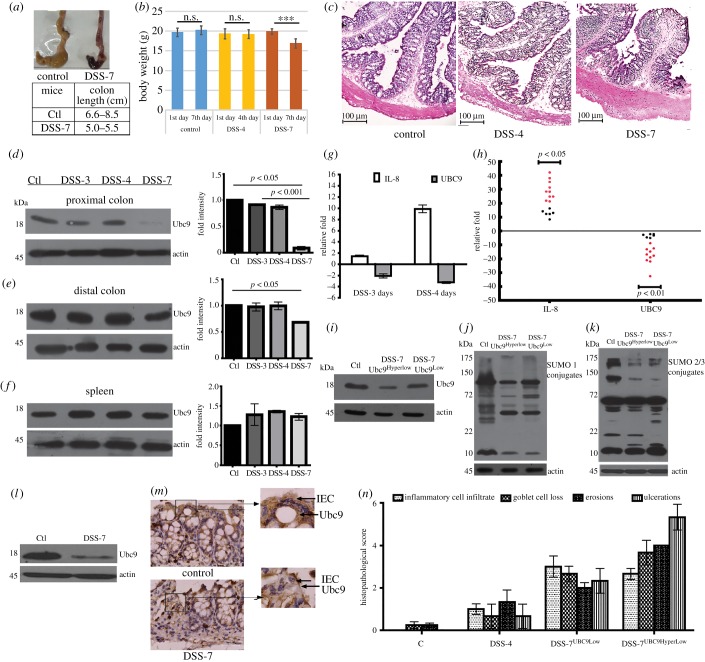
Downmodulation of Ubc9 expression in DSS-colitis mice. (a) Top, gross morphology of the caecum and colon of control and DSS-treated mice; bottom, table showing reduced lengths of the colon of control DSS-treated mice (DSS-7) (n = 6) compared with the control group. (b) Body weight of animals during the course of DSS treatment. (c) Haematoxylin and eosin staining of caecum of mice (scale bar, 100 µm) showing exacerbated inflammation in animals. Immunoblots of Ubc9 of lysates from the (d) proximal colon, (e) distal colon and (f) spleen. Densitometry analysis of Ubc9 protein shows lowered Ubc9 in inflamed tissue as represented by means ± s.e.m. from three independent experiments are shown on the right-hand panel in each (d,e,f). Actin was blotted as a loading control. (g) qPCR expression of DSS (3 and 4 days, n = 5) mice for Ubc9 and IL-8 genes of proximal colon. qPCR data were calculated as average fold change (relative to the control group). B2M and β-actin were used for normalization. (h) qPCR data of IL-8 and Ubc9 of DSS-7 mice compared with the control group represented as fold change (relative to control), each black dot represents one mice. Immunoblot representing the downmodulation of Ubc9 (i) and global SUMOylation: SUMO-1 proteome (j) and SUMO-2/3 proteome (k) in DSS-7HyperLow and DSS-7Low compared with control. (l) Immunoblot of Ubc9 from epithelial lysates indicating lowered expression. (m) Upper panel: IHC of colonic sections of control and DSS-7 mice (scale bar, 100 µm). Magnified regions shown in the inset. (n) The histopathology of the colon was quantified by using a disease severity index scale from (0 to 6), with 0 scored normal and a score of 6 showing the most substantial level of disease pathology. The sections were scored blind by a trained pathologist. Statistical significance was assessed (p < 0.001–0.05). β-Actin was used as loading control for all immunoblots.